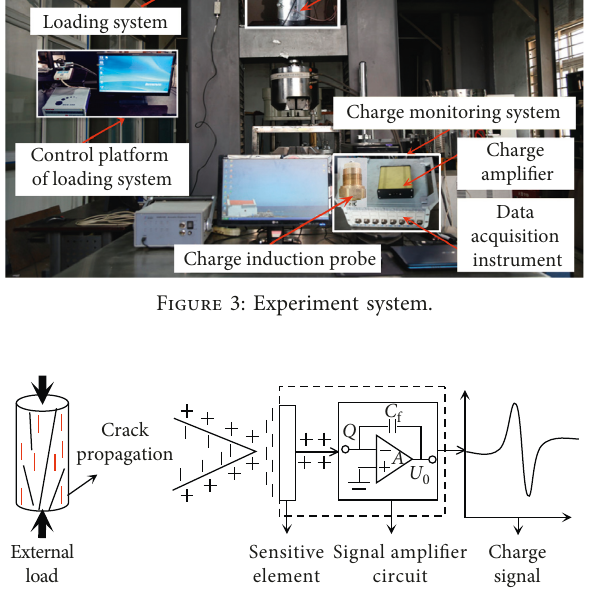
Figure 4: Coal-rock charge induction